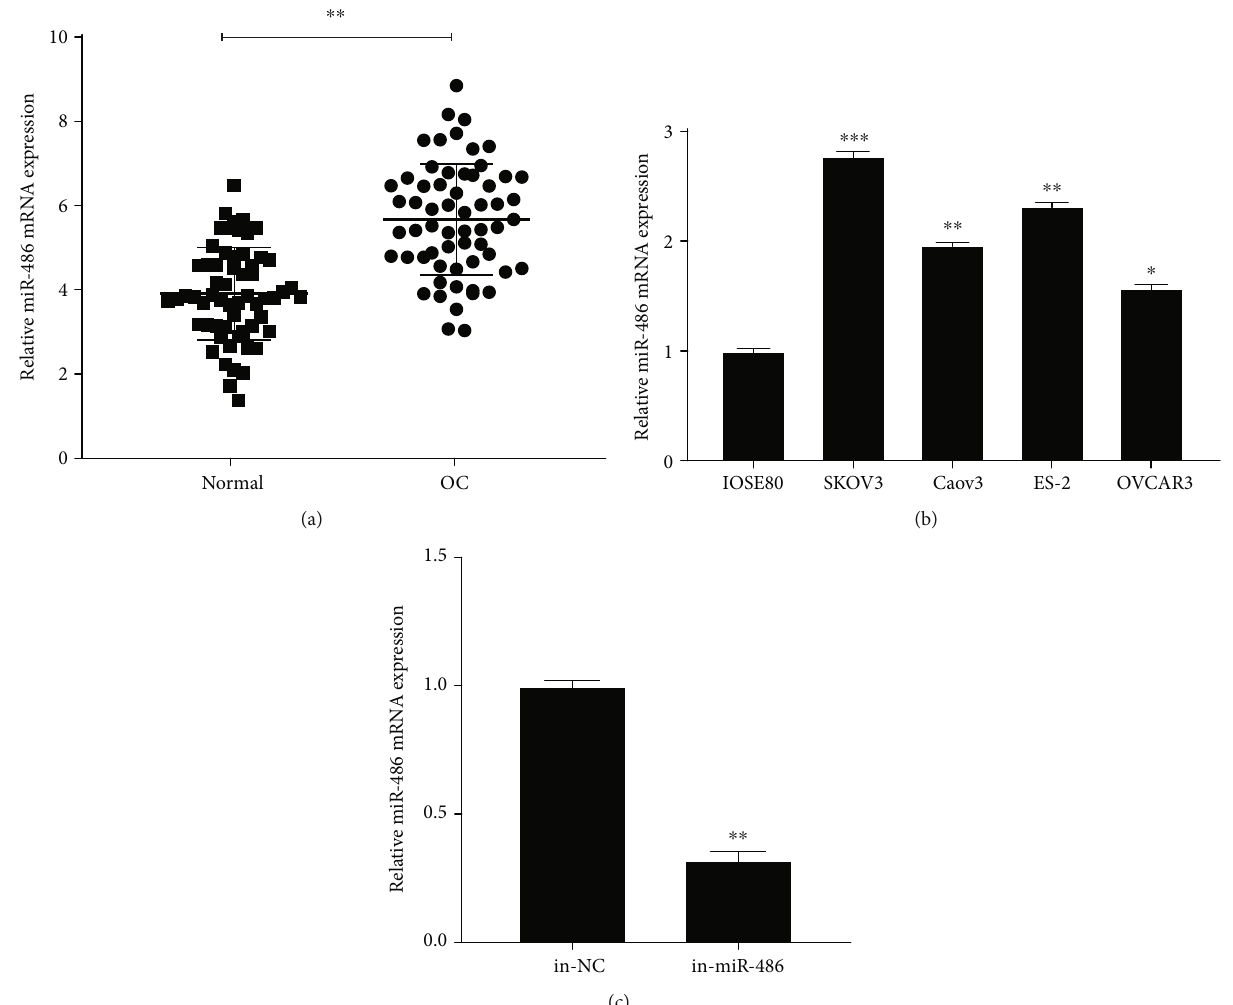
Figure 1: miR-486 is highly expressed in OC tissues and cells. (a) qRT-PCR to detect the expression of miR-486 in the OC tissues and the normal tissues. MiR-486 is highly expressed in OC tissues; (b) qRT-PCR to detect the expression of miR-486 in SKOV3, Caov3, ES-2, OVCAR3, and IOSE80; (c) qRT-PCR to detect the expression of miR-486 in SKOV3 after transfection with miR-486 inhibitor. ∗ P < 0 : 05 , ∗∗ P < 0 : 01 , and ∗∗∗ P < 0 : 001